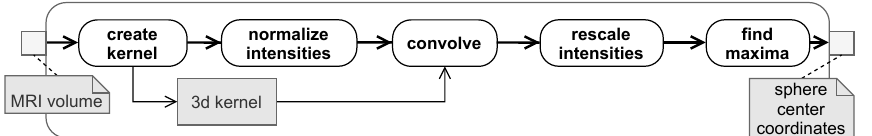
Figure 4. Pipeline for convolution-based sphere